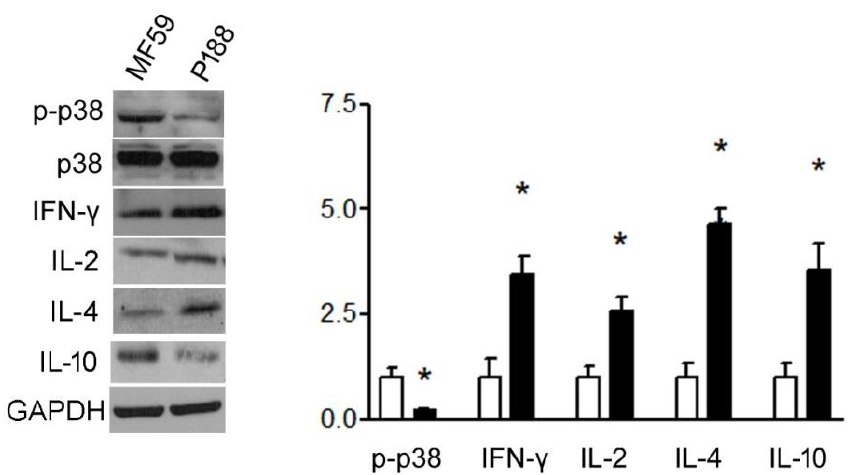
Figure 6. P188 up-regulated T-helper type 1 and 2 activity and down-regulated p38MAPK phosphorylation. Splenocytes from mice were cultured and stimulated by P188. Western blot and the bar graphic show that P188 repressed p-p38MAPK increase and significantly Th 1 cytokines, IFN- γ , and IL-2; whereas Th2 cytokines, IL-10, and IL-4 increased in splenocytes. All results are presented as mean ± SD. * p < 0.05 vs. control group.